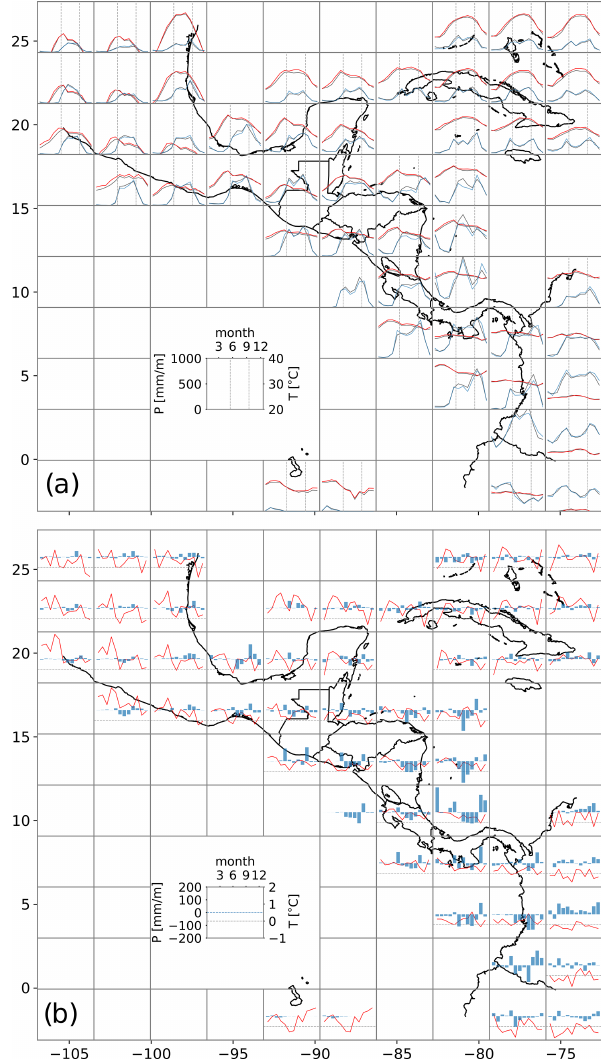
Figure 2. The study area with (a) climatological patterns of monthly precipitation (blue) and temperature (red) for the 1981–2020 period and (b) changes between the early (1981–2000) and later (2001– 2020) parts of the study periods, based on the CHIRPS (precipita- tion) and CHIRTS (temperature)